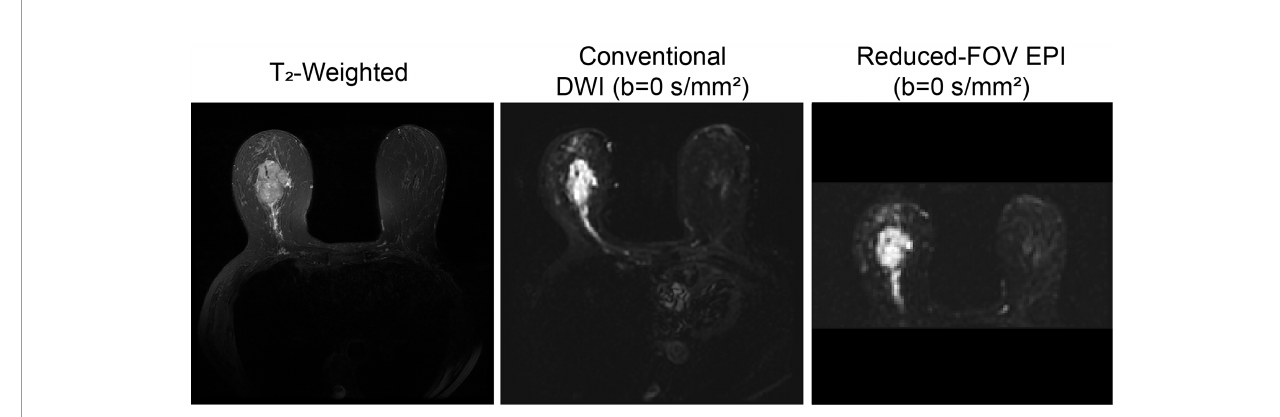
FIGURE 4 | Reduced FOV EPI in a 63-year-old patient with invasive ductal carcinoma. T 2 -weighted, conventional DWI (b=0 s/mm 2 ), full FOV EPI (b=0 s/mm 2 ), and reduced FOV EPI (50% phase fi eld of view) (b=0 s/mm 2 acquired at 3T) images are shown. Reduction of percent phase encoding direction to 50% reduces geometric distortions caused by B 0 -inhomogeneity, especially in the nipple region